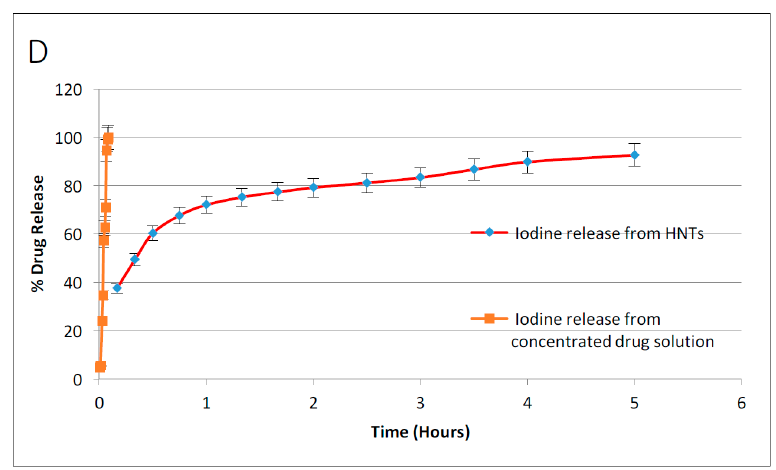
Figure 4. Release profile of antiseptics from HNTs. ( A ) Povidone iodine; ( B ) Chlorhexidine; ( C ) Brilliant green; ( D ) Iodine. n = 4 trials.